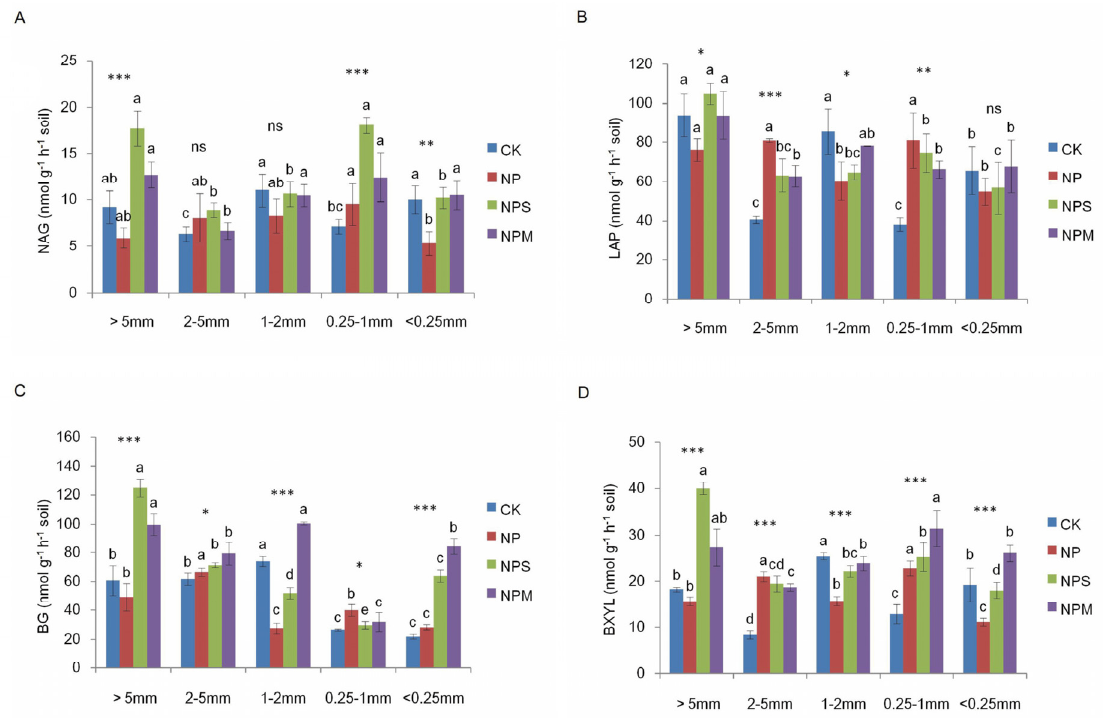
Figure 6. Histogram of N–acetyl–glucosaminidase ( A ), leucine aminopeptidase ( B ), β –glucosidase ( C ), and β –xylosidase ( D ) activities in aggregates in different treatments. NAG: N–acetyl–glucosaminidase; LAP: leucine aminopeptidase; BG: β –xylosidase; BXYL: β –xylosidase. Different lowercase letters mean significant differences among aggregate size fractions ( p < 0.05). The differences in the four enzymes’ activities across fertilization managements are shown at *: p < 0.05, **: p < 0.01, ***: p < 0.001, and ns: not